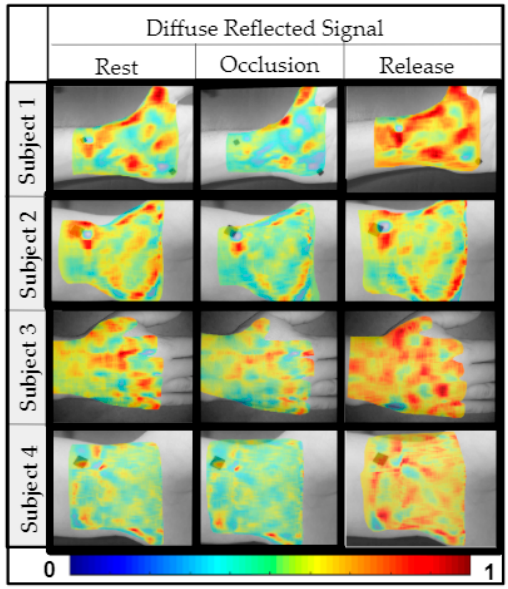
Figure 9. Reconstructed diffuse reflectance images across the three time stamps and all four subjects. The reconstruction was performed using EVs 4:15.